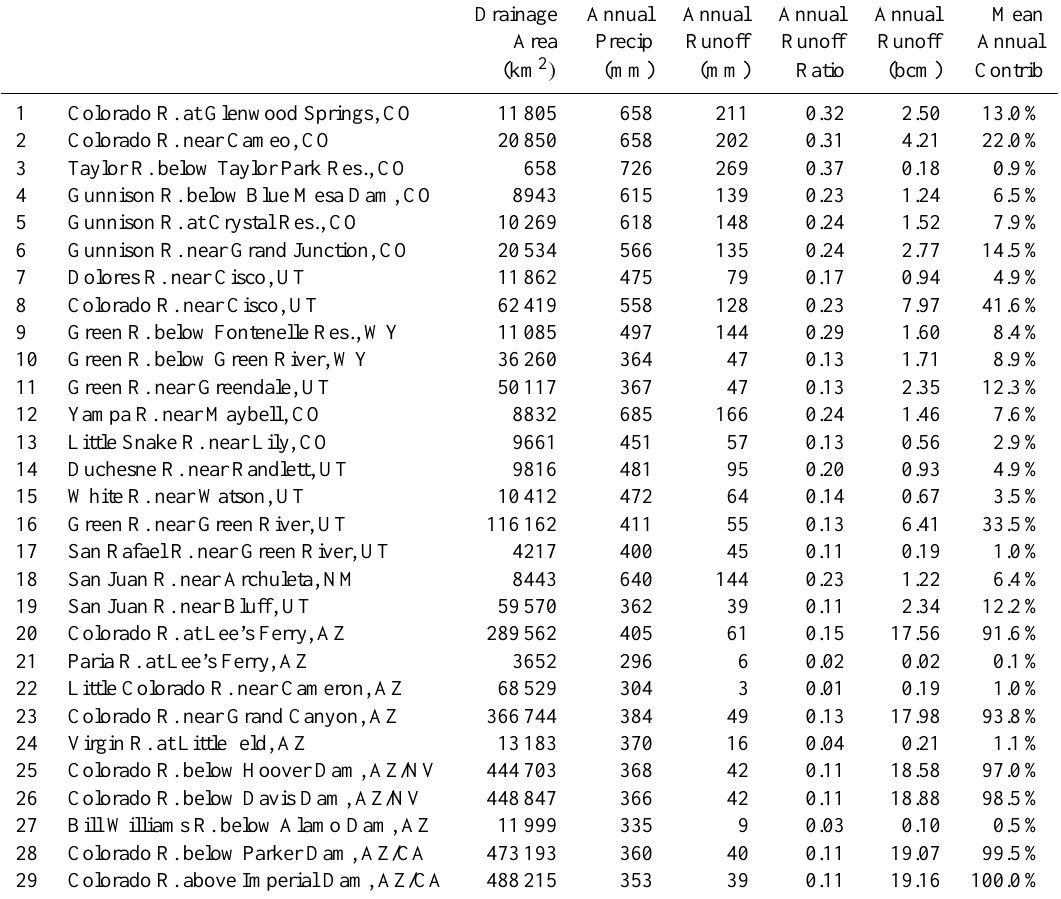
Table 1. Average annual statistics for the 29 sub-basins over water years 1950–2008. The annual runoff ratio is defined as the ratio of annual runoff to annual precipitation. The mean annual contribution represents the percentage of the total runoff at Imperial Dam (station 29).